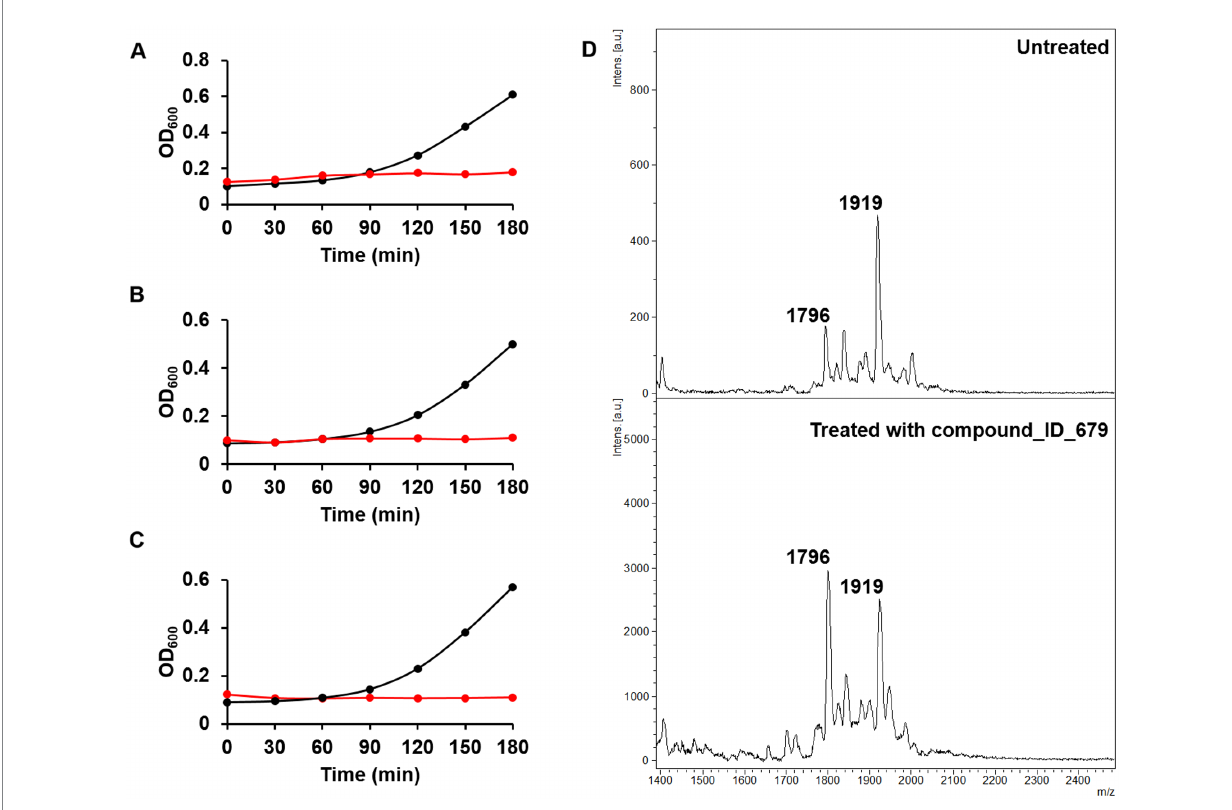
FIGURE 3 Phenotypic assays for the discovery of new compounds targeting mcr-1-producing E. coli. (A) Growth curves of untreated (black) and compound ID_100-treated E. coli (red). (B) Growth curves of untreated (black) and compound ID_264-treated E. coli (red). (C) Growth curves of untreated (black) and compound ID_499-treated E. coli (red). (D) Mass spectra of untreated (top) and compound ID_679 (250 μ M)-treated E. coli J53-mcr1 (bottom).